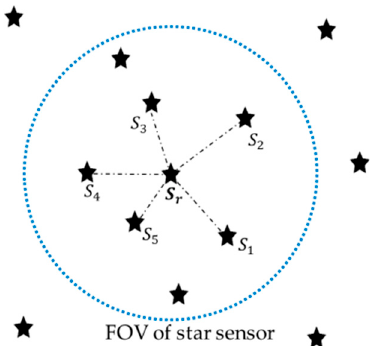
Figure 2. Illustration of the selected reference star and nearest five stars.